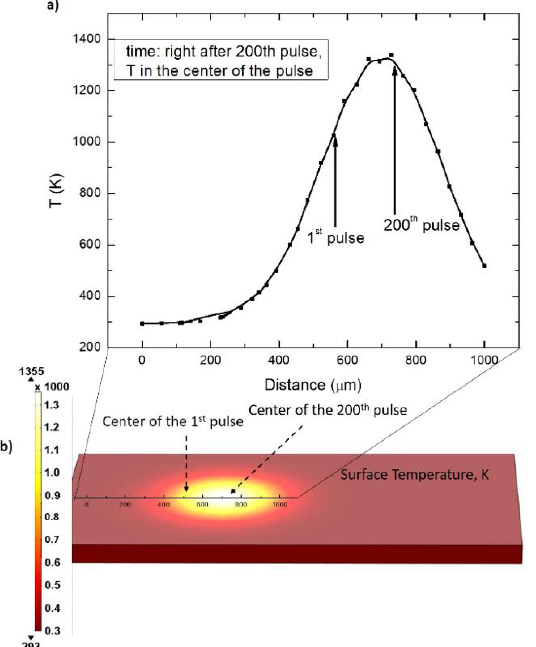
Figure 11. Temperature distribution right after the 200th pulse (where the beam was translated for